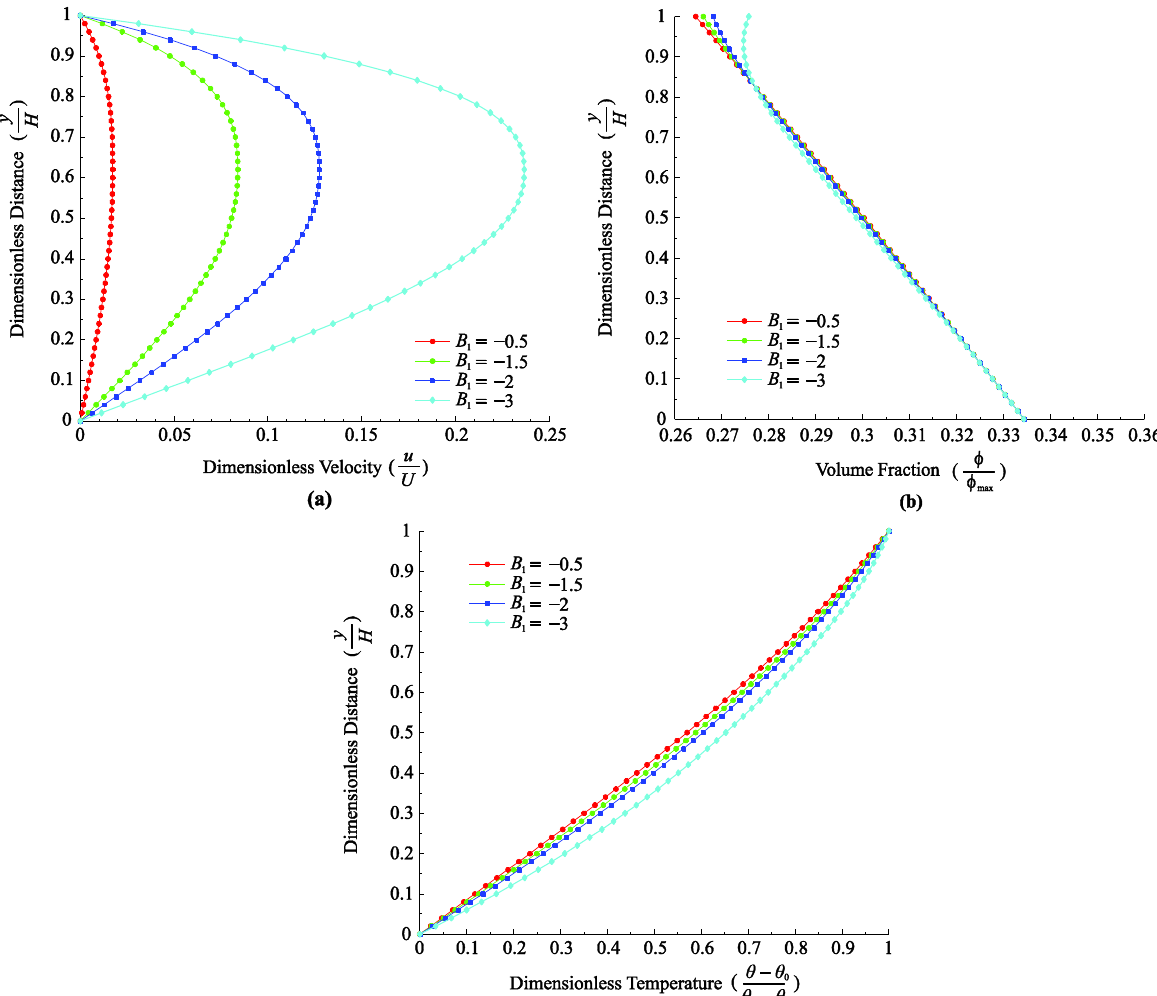
Figure 6. ( a ) Effect of 𝐵 volume fraction distribution. ( c ) Effect of 𝐵 𝑚 = −0.3, 𝑀 = 1, 𝐵 −0.02, 0.01, 2.3, −9, 11